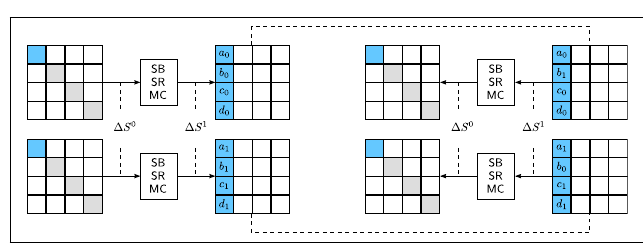
Figure 10: Left : A pair that maps a single-byte difference to a four-byte difference ∆ S 1 through the first round. If this pair produces a desired difference after almost five rounds, then, there exist seven further mixture pairs (e.g., one is depicted right ) of the variables after the first round that have the same difference ∆ S 1 . Thus, they must have had the same difference before MixColumns , and therefore must also stem from δ -sets of the first